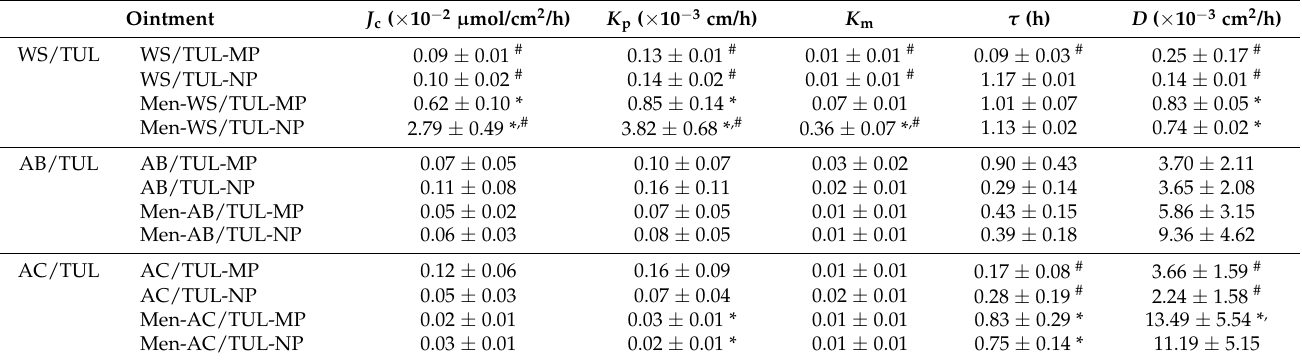
Table 3. Pharmacokinetic analysis of TUL transdermal formulations in the in vitro penetration of rat skin.